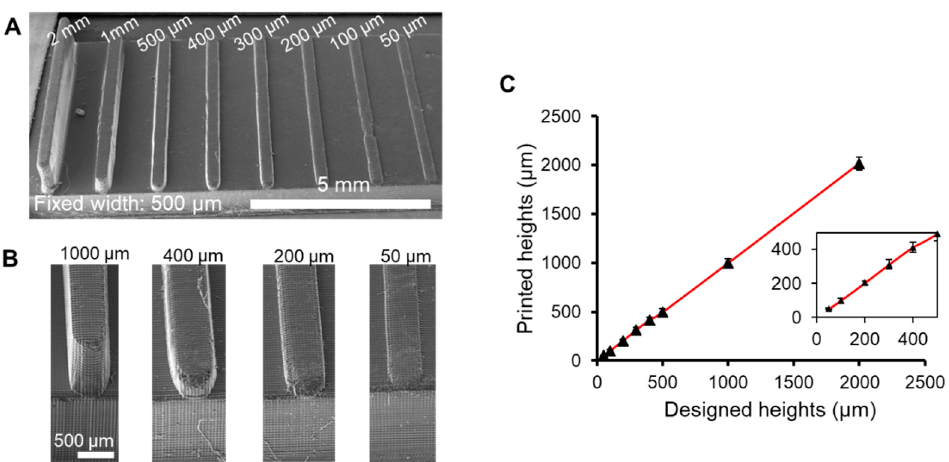
Figure 3. Characterization of feature resolution in the vertical direction. ( A ) SEM images of the line patterns printed for characterization. The widths of the patterns were fixed at 500 µm. ( B ) The zoom-in images of the line patterns with the designed heights of 1000, 400, 200, and 100 µm. ( C ) Relationship between designed heights and printed heights. The printed heights are almost same as the designed one and not affected by the overcuring.